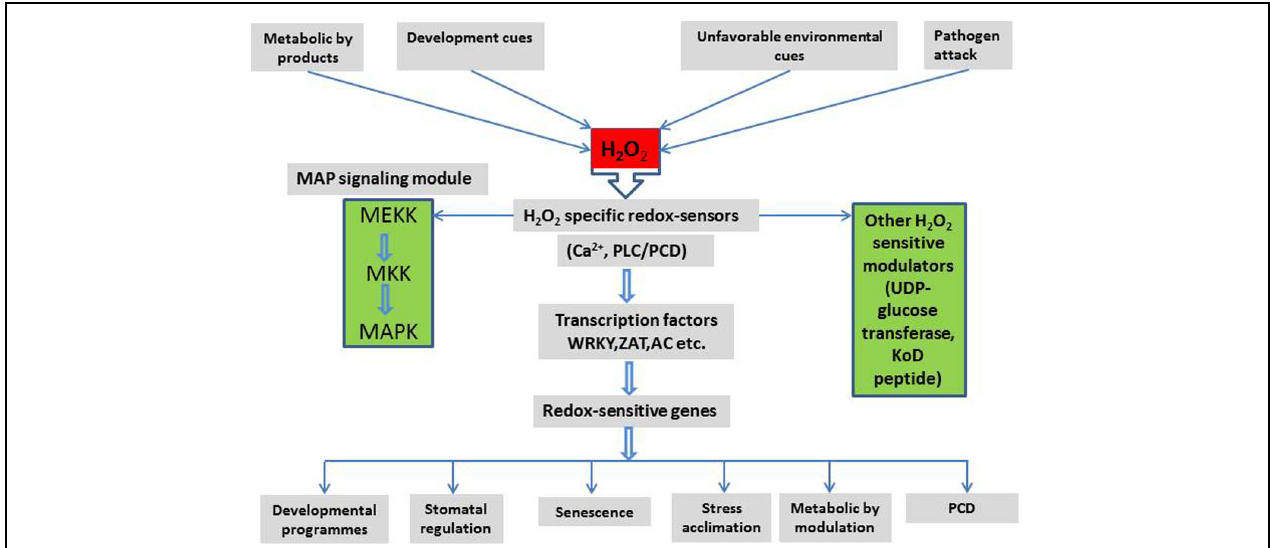
FIGURE 3 | A schematic representation of major signaling components and their interactions in the H 2 O 2 signaling network and the possible outcome in plant cells (Detail in text).